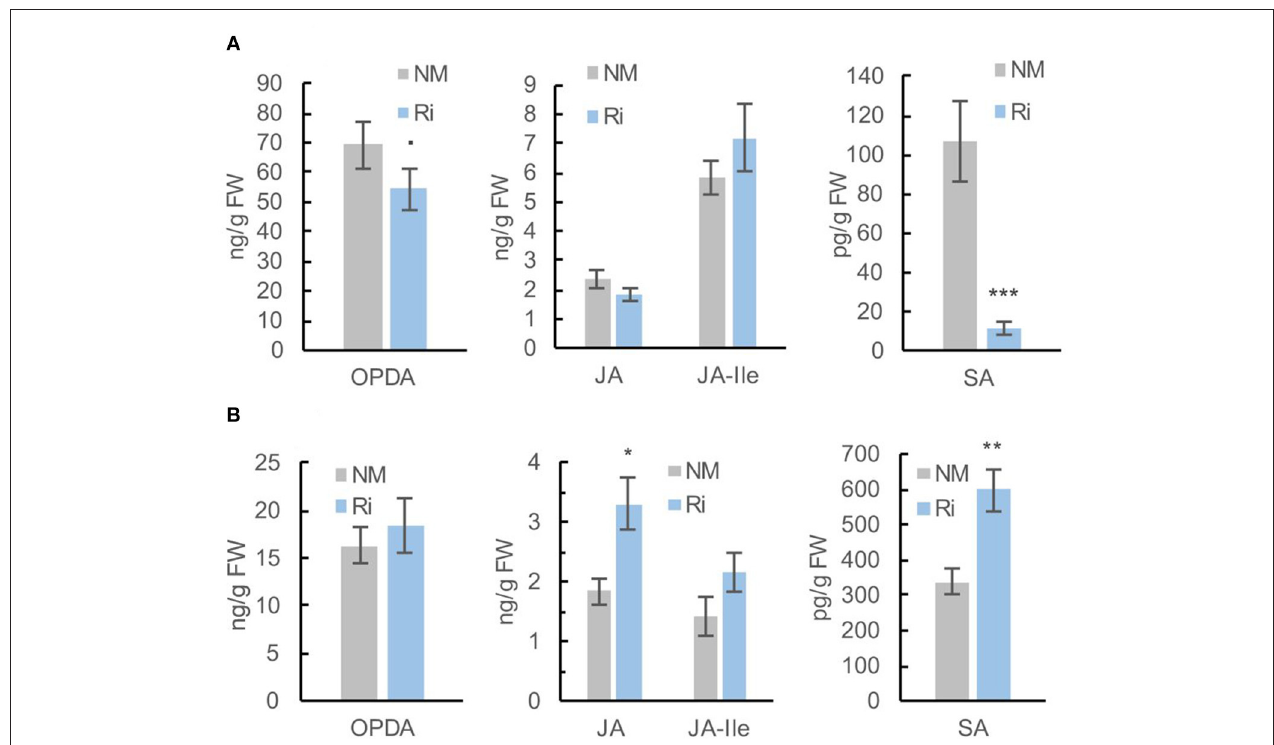
FIGURE 5 | Levels of jasmonates (OPDA, JA, and JA-Ile) and salicylic acid (SA) in roots (A) and leaves (B) of Ri and NM grapevines, 2 months after mycorrhization. Data are mean ± SE of 8 independent biological replicates. Asterisks indicate significant differences between NM and Ri conditions (Kruskall and Wallis, *** p < 0.001, ** p < 0.01, * p < 0.05, · p <